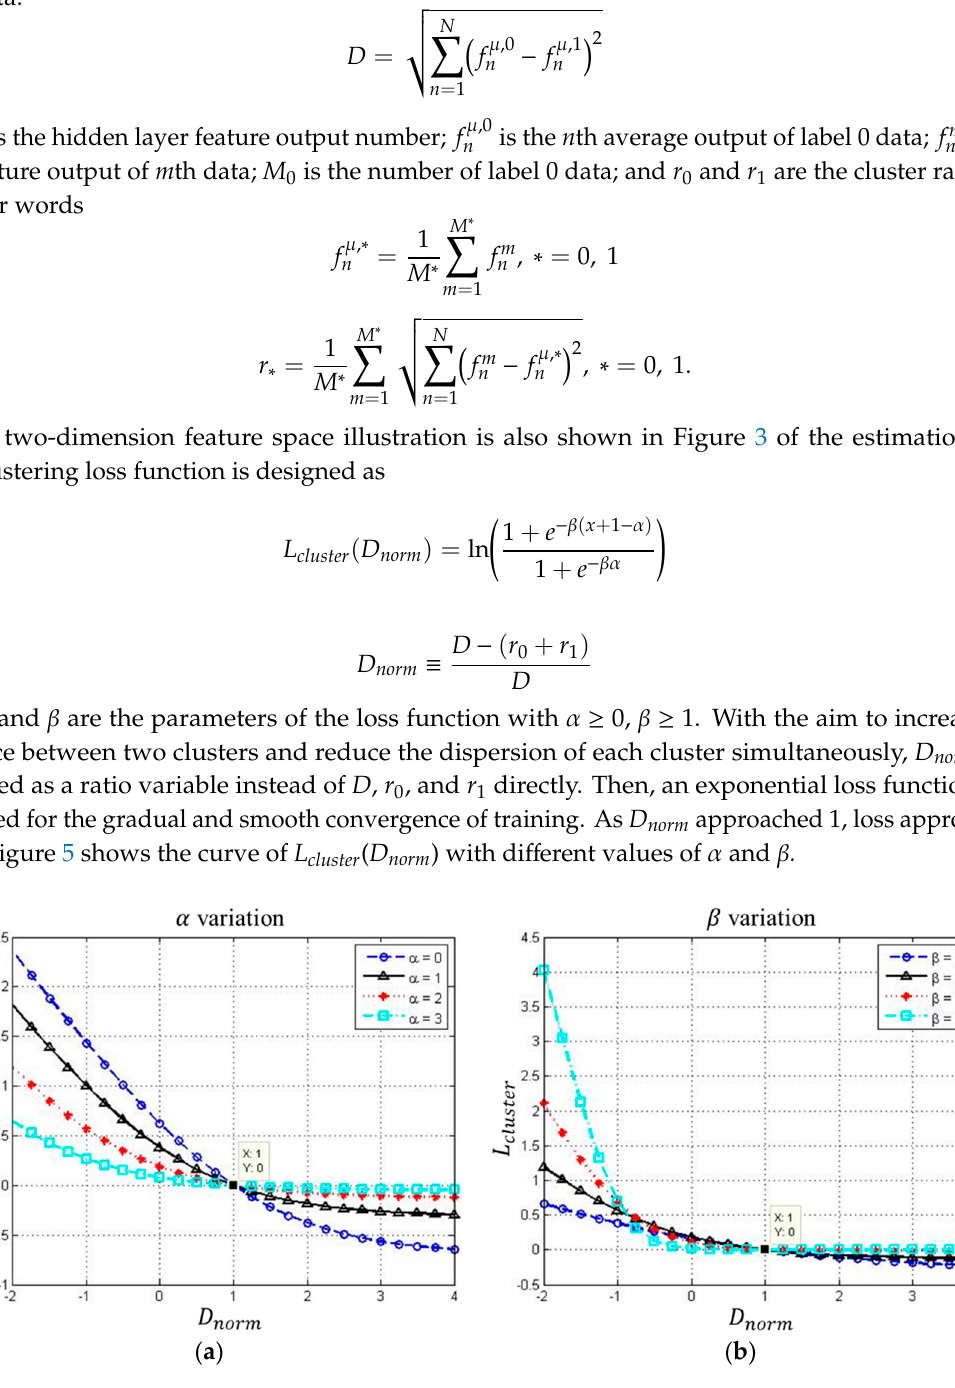
Figure 5. The visualized loss function curve, ( a ) α variation; ( b ) β variation.